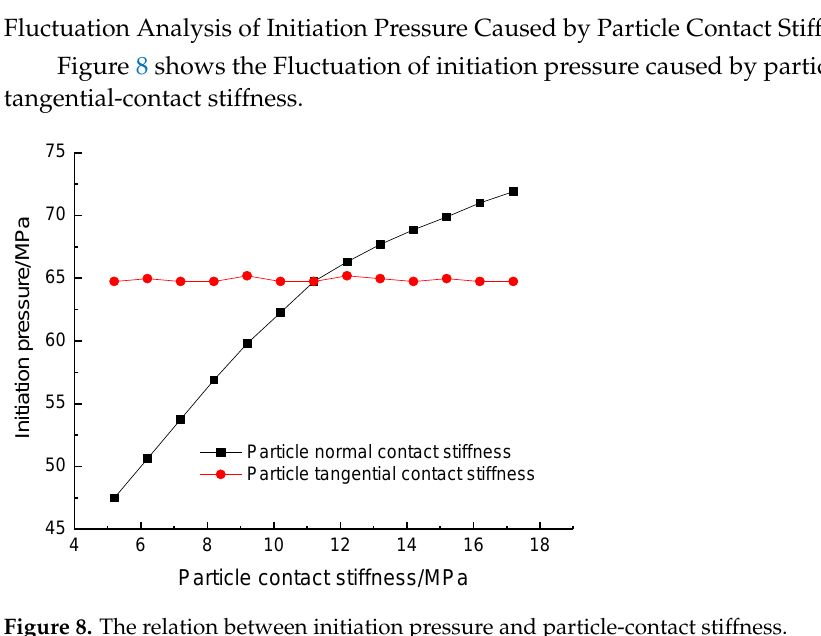
Figure 7. The relation between initiation pressure and horizontal principal stress. From Figure 7, it can be seen that the key control-principal stress of fracture-initiation is the horizontal minimum principal stress. The increase of the minimum principal stress makes the fracture-initiation pressure of the wellbore increase, and the increasing change is almost linear. However, the increase of the horizontal maximum principal stress has little effect on the fracture initiation pressure. Thus, it is confirmed that the formation fracture is along the direction of the maximum principal stress.